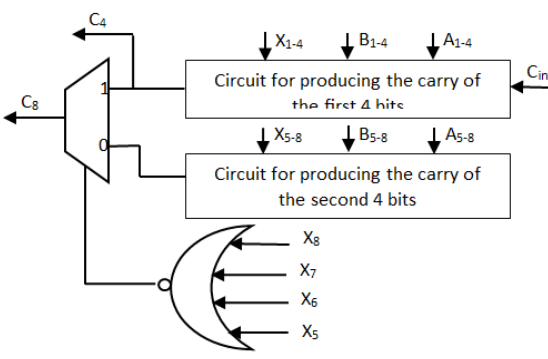
Figure 7. Proposed circuit for calculating the eighth bit carry.